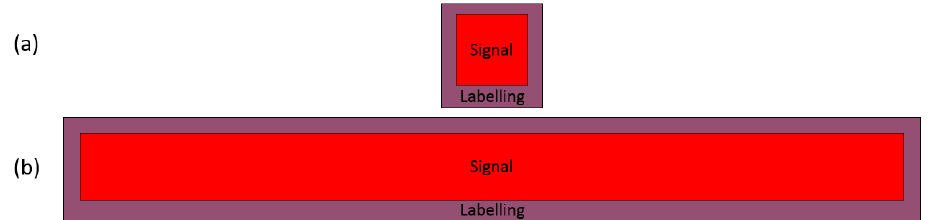
Figure 6. The two types of ionogram signals: ( a ) compact and ( b ) elongated. The area of the signal is shown in red, and the labeled area is shown in